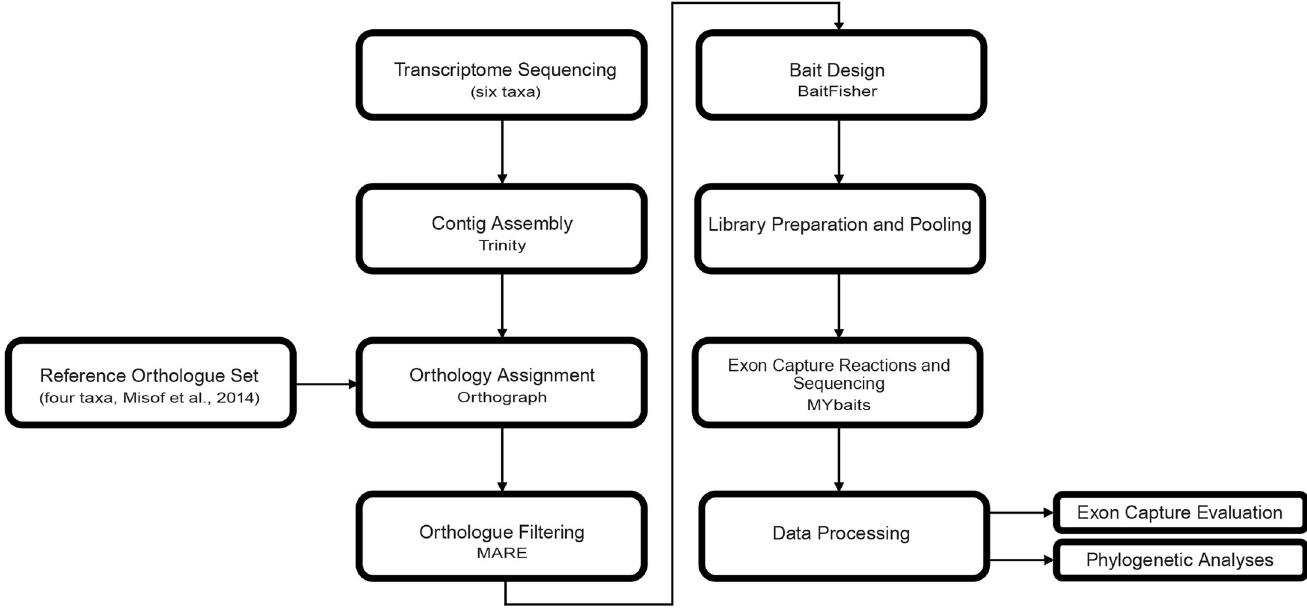
Fig 1. Schematic overview detailing the methodological framework used for orthology assignment, bait design and sequence data generation.